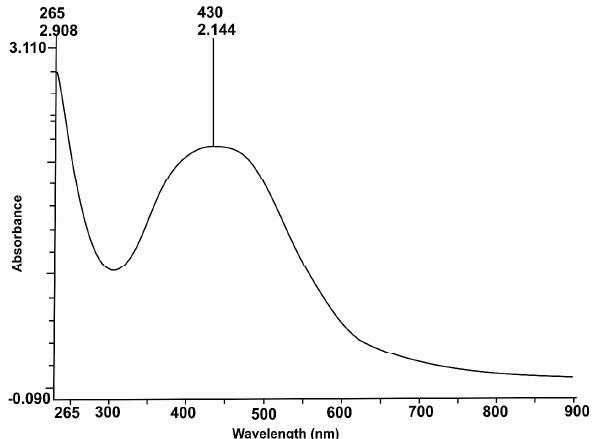
; C- UV Acr ; D- control) 10 10 8